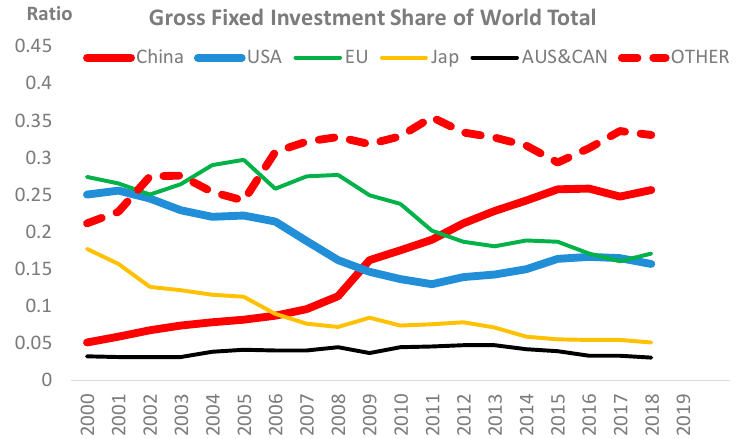
Figure 2. Gross Fixed Investment by Country as a Share of the World Total. Source: Thomson Reuters. Chinese import penetration in the West, together with its own failure to consume, come at a cost to the West in the form of loss of jobs and downward pressure on real wages for workers at the lower end of the education and skill distribution. Companies in the West have adapted to the unlevel playing field transformation of global supply chains, while moving up the value-added chain and cutting costs through digitalisation.